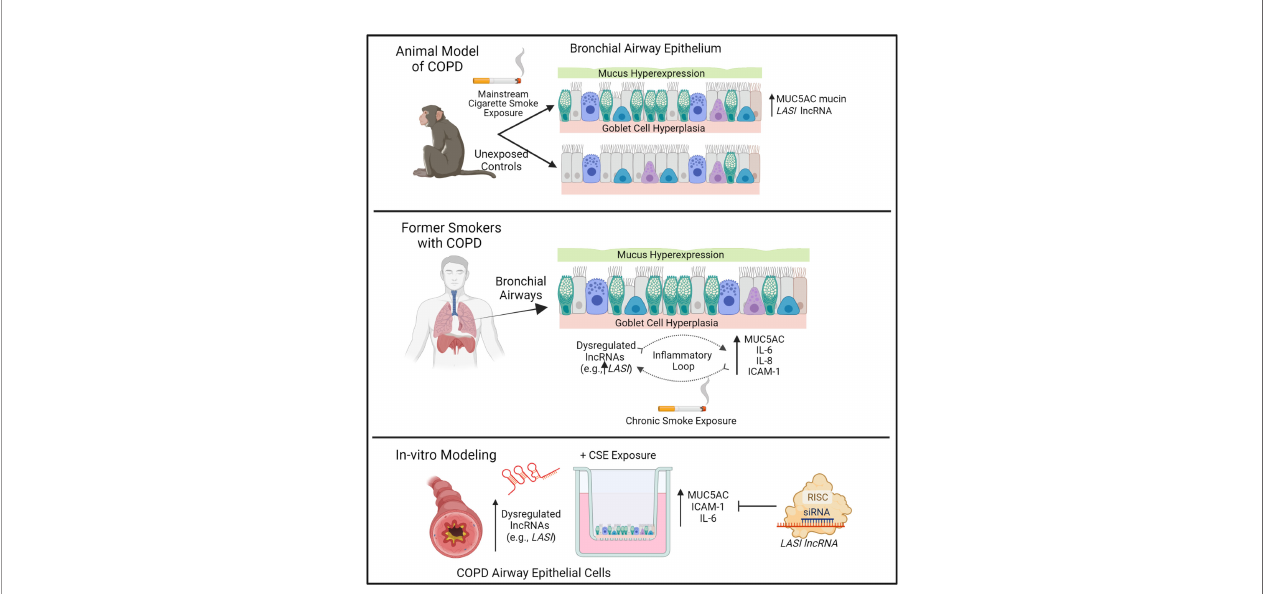
FIGURE 7 | Schematic representation on the potential role of bronchial epithelial LASI lncRNA in CS-induced and COPD-associated airway mucus hyperexpression and in fl ammatory